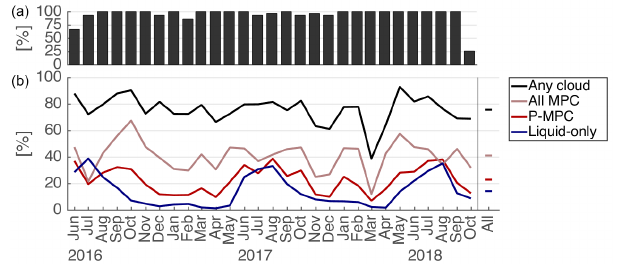
Figure 5. Monthly and total occurrence frequency of clouds in gen- eral and selected specific cloud types (see text for definitions) (b) and coverage of Cloudnet data (a) .